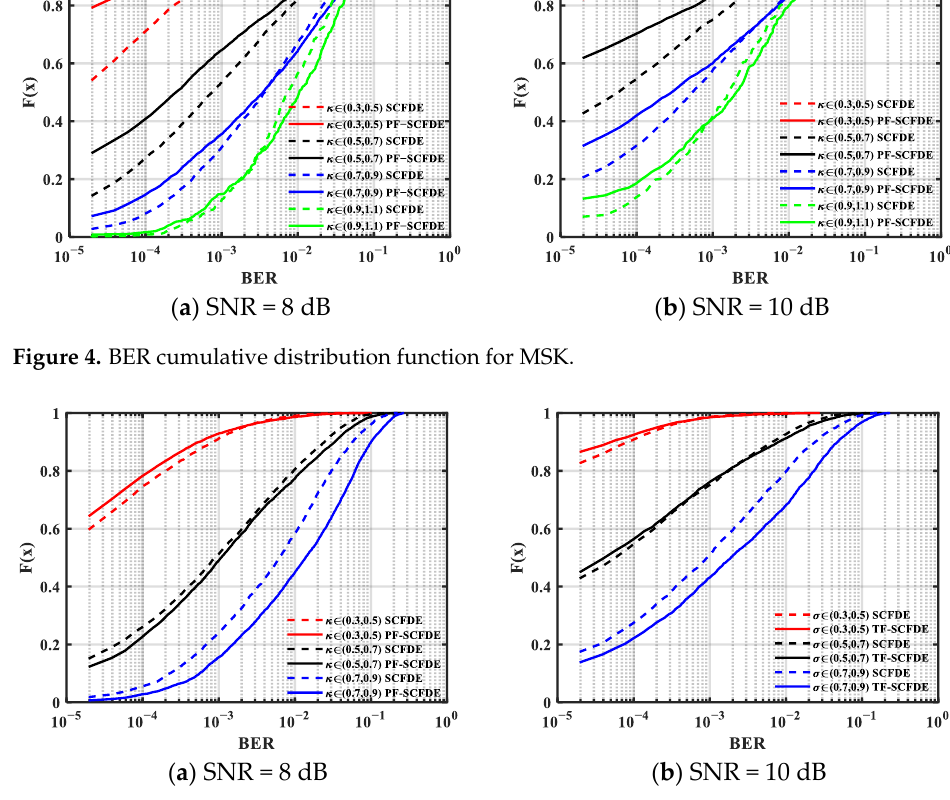
Figure 5. BER cumulative distribution function for GMSK.